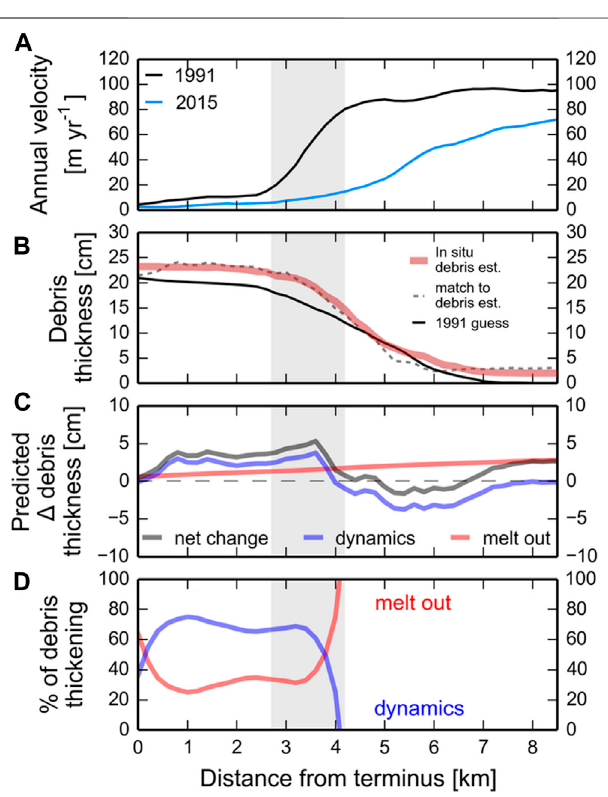
FIGURE 5 | The debris feedback expressed on the surface of Kennicott Glacier. For all panels the zone of maximum thinning (ZMT) is shown in grey. (A) Annual surface velocities from 1991 to 2015 from the swath pro fi le. (B) In situ debris thickness from 2011. The best estimate of the debris pattern in 1991 is shown as well as the simulated debris thicknesses in 2011 produced from the inversion assuming a uniform englacial debris concentration. (C) Predicted absolute change in debris thickness from 1991 to 2011 due to dynamics and debris melt out. (D) The relative role of ice dynamics and debris melt out in debris thickness change. Above the ZMT debris melt out accounts for 100% of the debris thickening because fl ow is high and ice dynamics tends to thin debris by advection